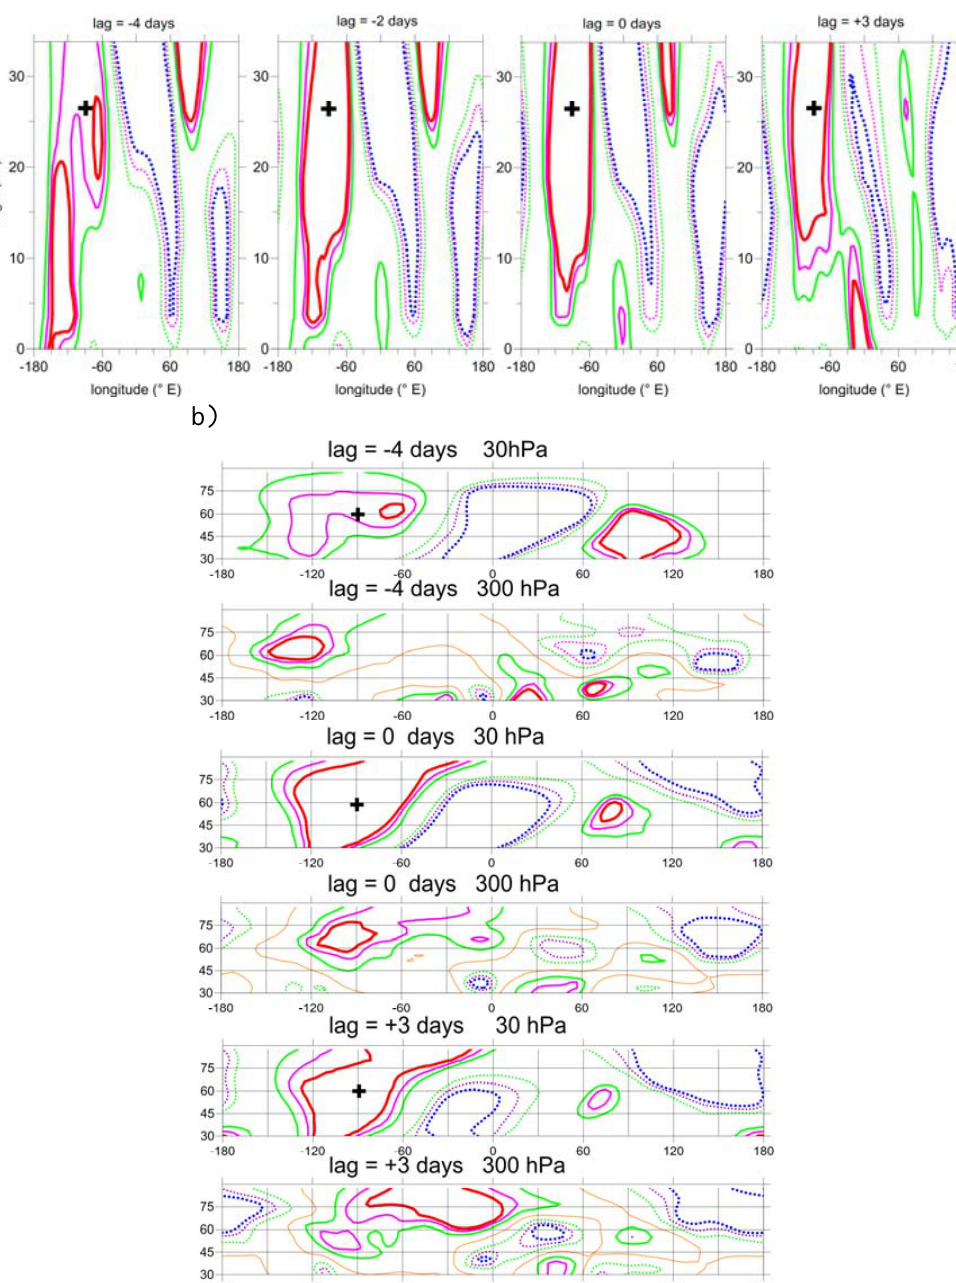
Figure 14: Lag-correlation of geopotential height anomalies with the reference point (90° W, 60° N, 30 hPa) for January 2003 (a) altitude-longitude cross sections at 60° N and (b) latitude- longitude cross sections at 30 hPa (upper panel) and 300 hPa (lower panel) for {-4, -2, 0, +3} day lags. Lines are shown for 80, 90 and 95 % confidence levels respectively. The cross marks the position of the reference point (90° W, 60° N) at 30 hPa.